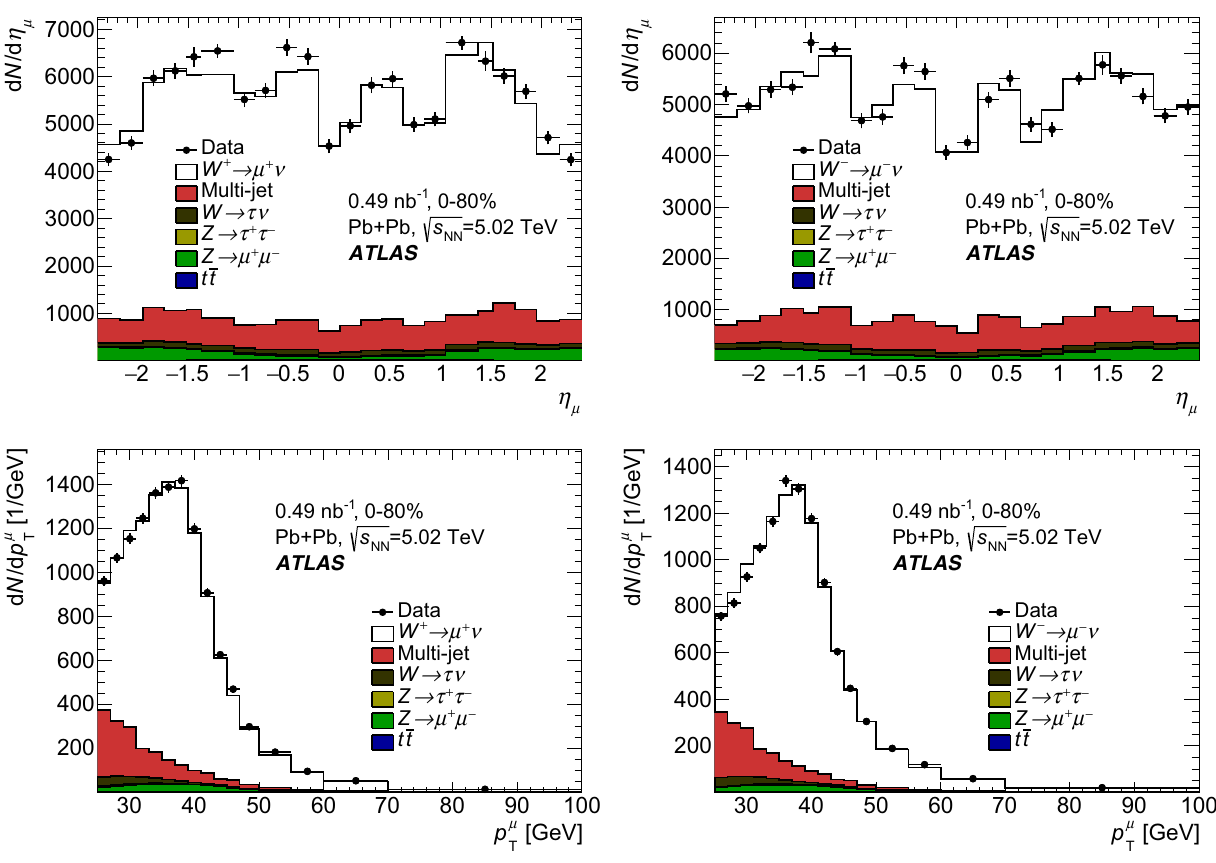
Fig. 3 Detector-level distributions of W + (left) and W − (right) event candidates decaying in the muon channels after all selection require- ments as a function of the muon pseudorapidity (top) and transverse momentum (bottom). The contributions of EW and top-quark back- grounds are normalised according to their expected number of events